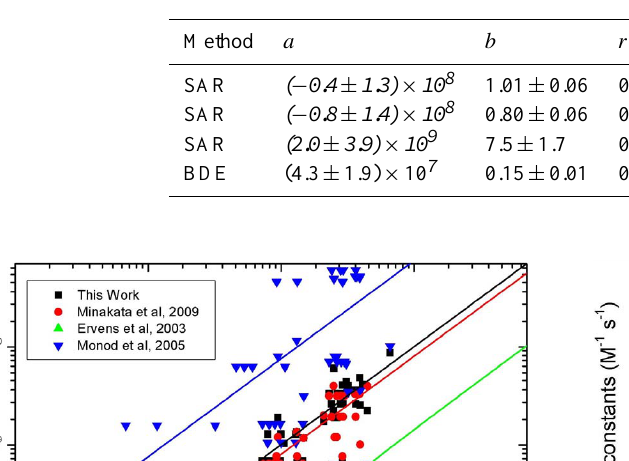
Table 7. Comparison of the linear regressions obtained for the correlations between experimental and calculated values for various estimation methods as shown in Fig. 4. The linear fit follows the general equation y = a + b · x and r 2 is the square of the correlation coefficient, and n is the number of data. Italics indicate the values which are not statistically significant i.e. much smaller than their associated uncertainty.